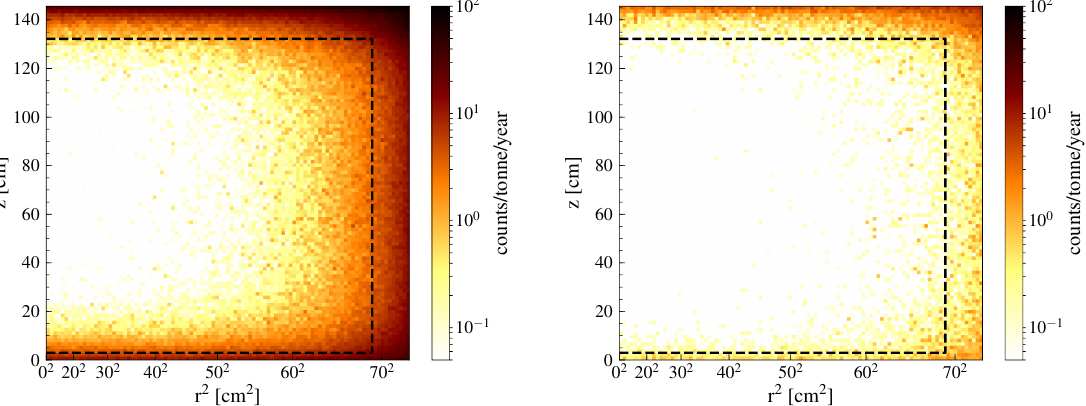
Figure 5. ( Left ) Positions of single hit NR events in the region of interest relevant to a 40 GeV/c 2 WIMP (approximately 6–30 keV) with no vetoing. The total count for the 5.6 tonne fiducial volume (dashed line) is 10.43 events/1000 days. ( Right ) Similar scatter plot, but after rejecting events in coincidence with the xenon skin (above 100 keV threshold within the time window of 800 µ s limited by the maximum drift time) and the outer detector (above 200 keV threshold within the time window of 500 µ s). The total background from NRs is now reduced to 1.03 events/1000 days